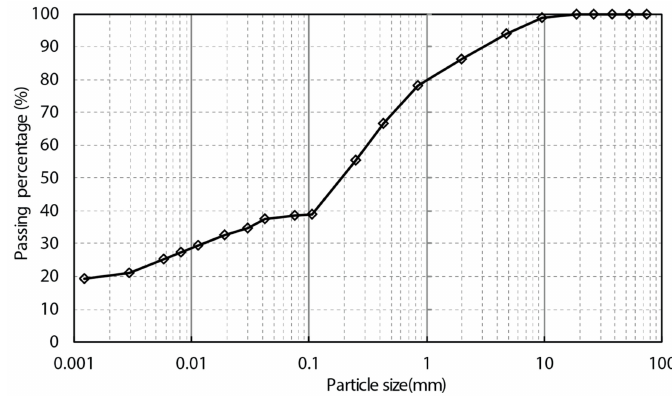
Figure 3. Particle size distribution of the rammed earth soil used.